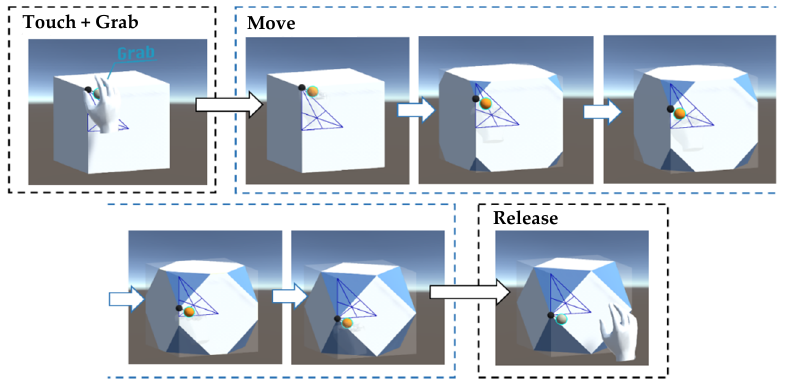
Figure 2. Screenshot of the process of one user taking notes in the task panel using the pen function.